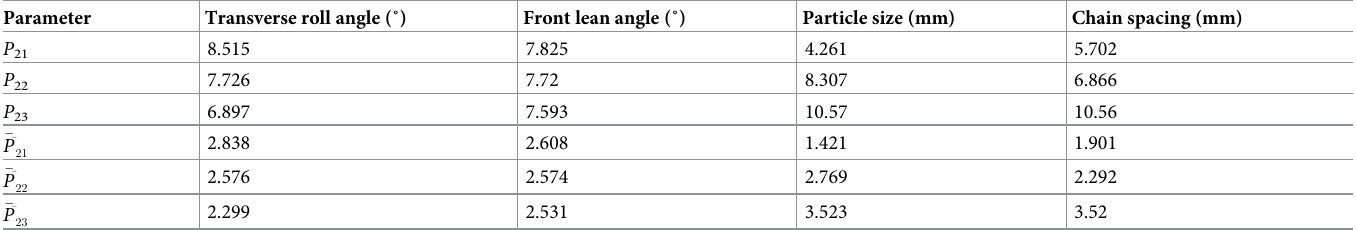
Table 11. Normal accumulative contact energy (kJ) under the different conditions.